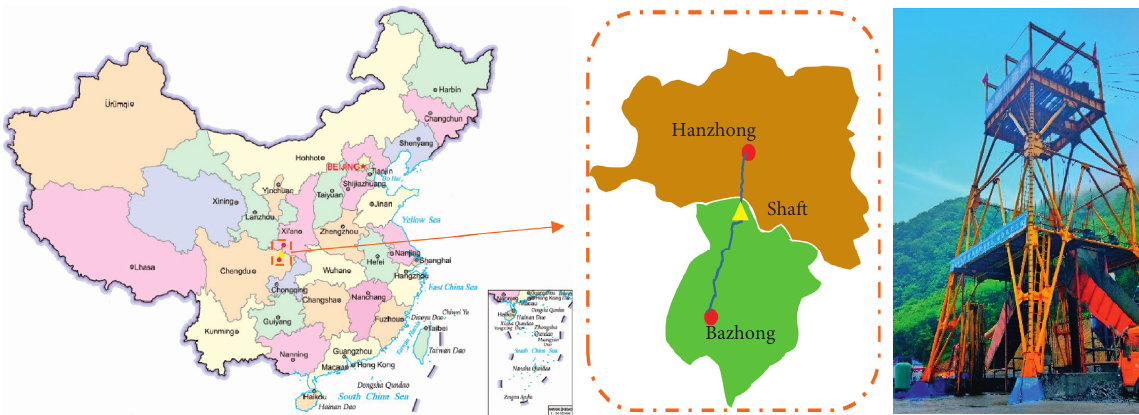
Figure 2: The geographical position of shaft. Table 1: Intact rock mechanical